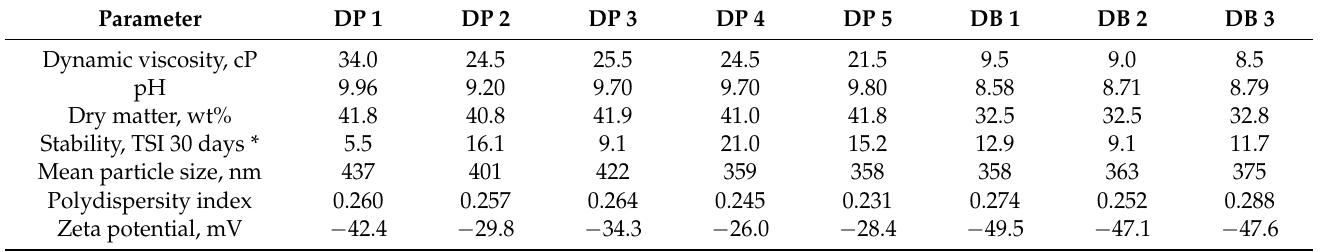
Table 3. Properties of obtained dispersions. DP—paraffin-based dispersions, DB—beeswax-based